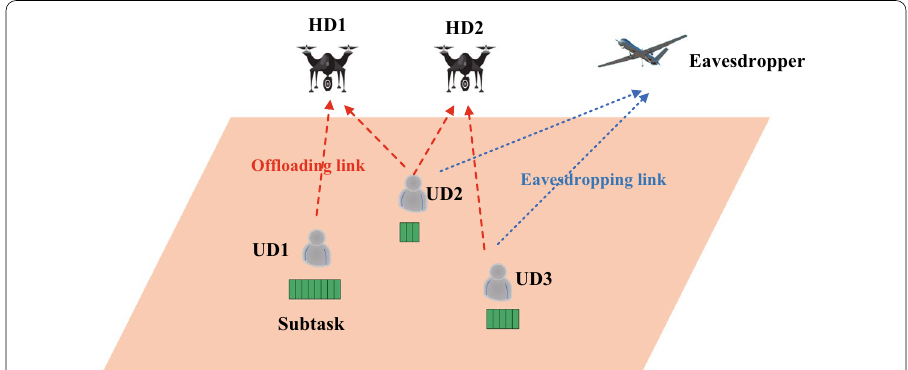
Fig. 1 The illustration of UAV-enabled air-ground MEC